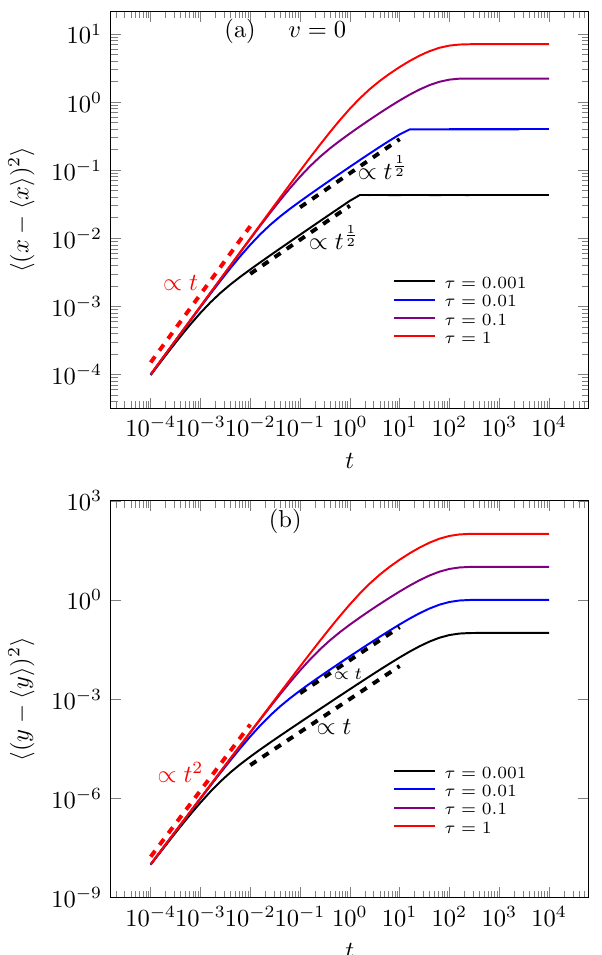
Figure 6. These figures represent time evolution to MSD behaviors to static stochastic resetting, i.e., v = 0. Figure ( a ) represents the MSD associated to Equation (31) and Figure ( b ) represents the MSD associated to Equation (32) to different τ valuers. Both figures consider the parameter valuers as = = 1 and κ = 0.02. follows K x K y